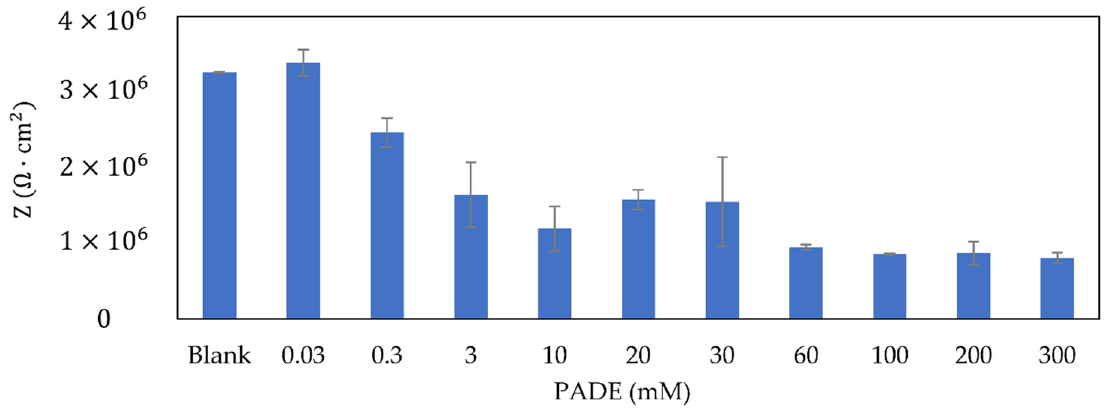
Figure 9. The impedance of the PADE membrane with different PADE concentrations.